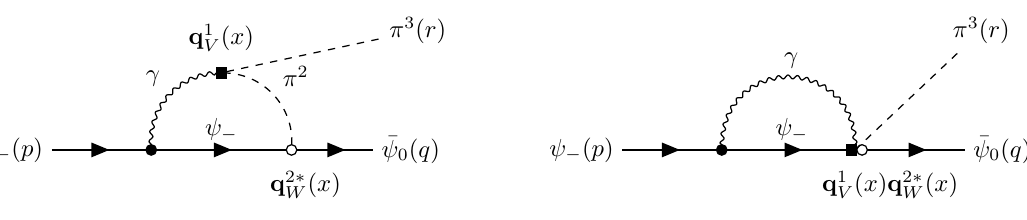
◦ are the separated